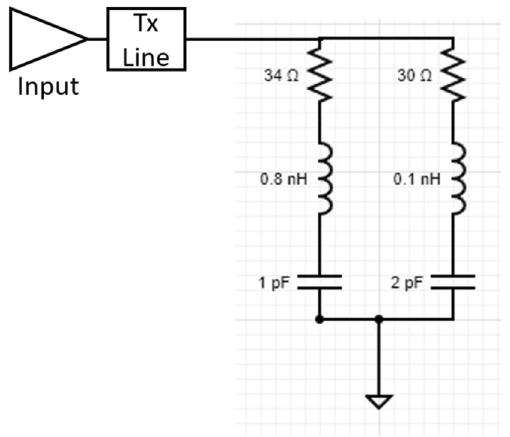
Figure 5. Equivalent circuit of the proposed antenna.